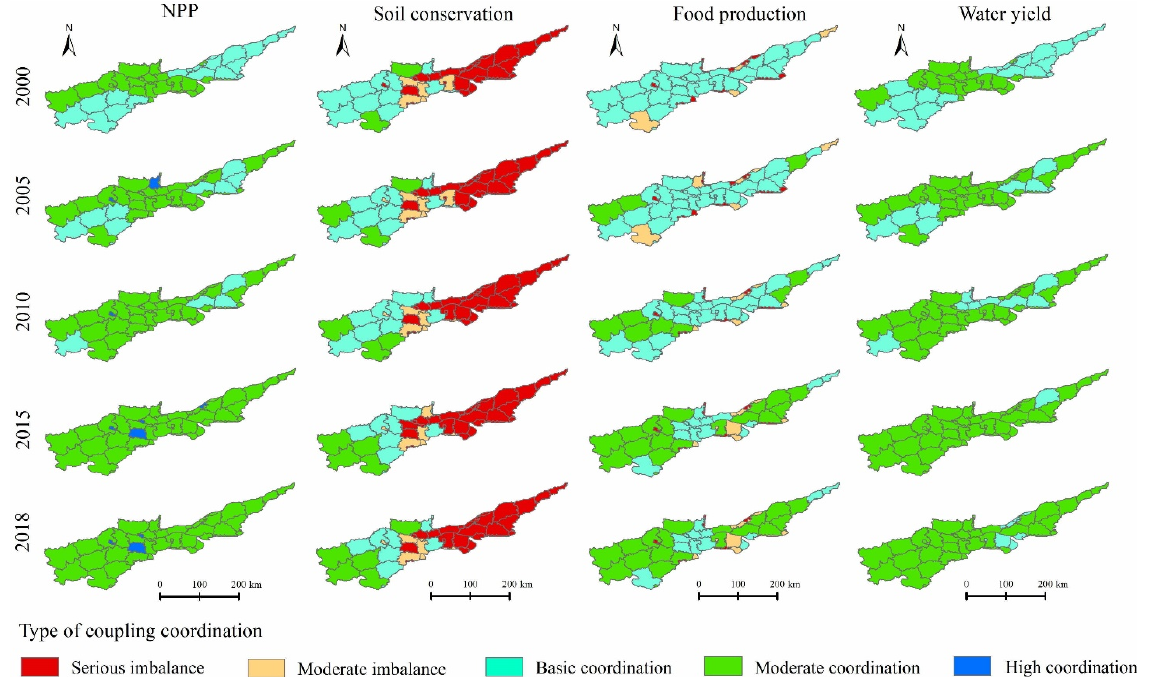
Figure 10. Spatiotemporal change in the coupling coordination between ESs and comprehensive urbanization in the AYRHP.